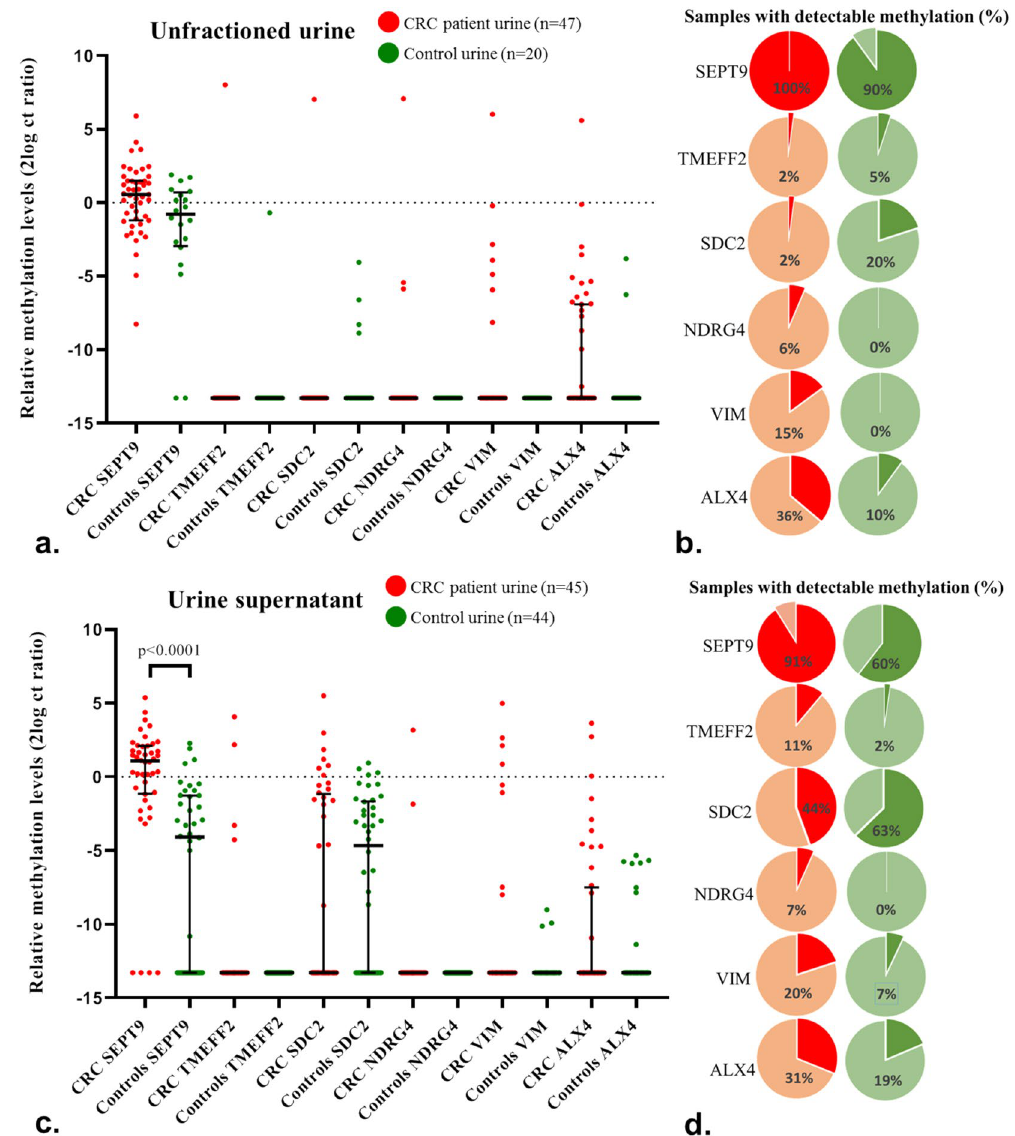
Figure 1. Methylation levels (a + c) and detection rates (b + d) in both unfractioned urine and urine supernatant samples. ( a , c ) Shows methylation detection of SEPT9, TMEFF2, SDC2, NDRG4, VIM and ALX4 in unfractioned and supernatant urine samples of CRC patients and controls. Data are shown as the median with interquartile range of 2log converted Ct ratios. In b , c , detection rates of markers in unfractioned urines and supernatant samples of CRC patients and controls are depicted, meaning the percentage of samples scoring a CtMARKER value below